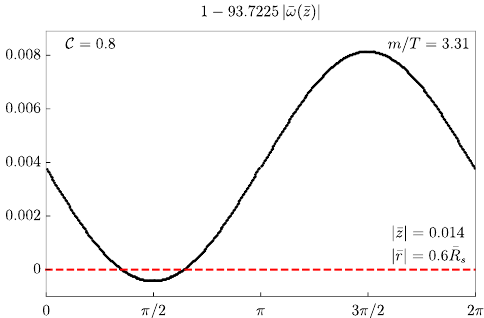
Figure 10 . A check of the sufficient condition (5.12) for establishing the violation of the conformal bound on the speed of sound applied to the longitudinal sound mode in Case I L . The black line indicates the value of the function (5.13) with respect to the argument of ¯ z , i.e., φ ∈ [0 , 2 π ] . The chosen values of parameters are C = 0 . 8 and | ¯ r | = | r | / (2 πT ) = 0 . 6 ¯ R s ( | ¯ z | = 0 . 014